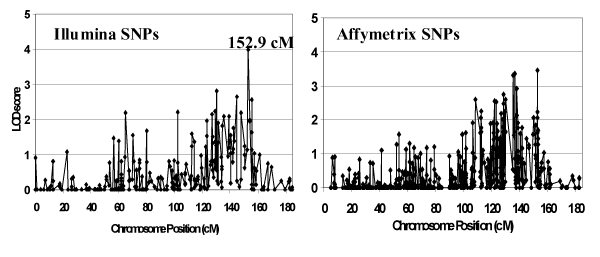
Age- and sex-adjusted SNP two-point VC analysis for ttth1 on chromosome 7. Age- and sex-adjusted SNP two-point VC analyses for quantitative trait ttth1 on chromosome 7.